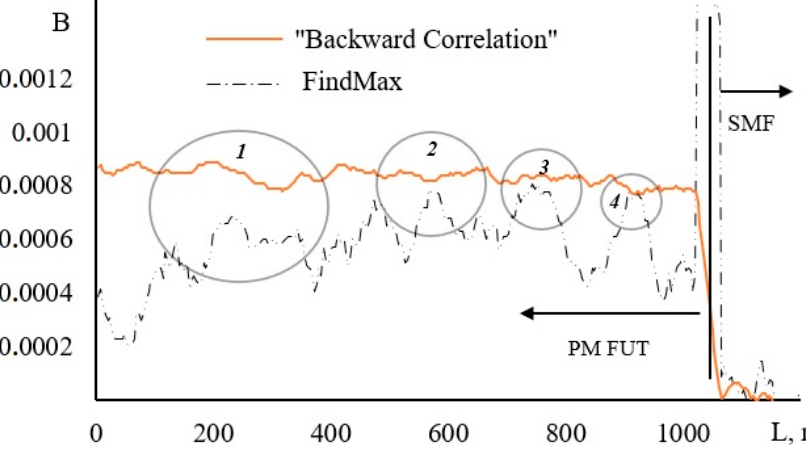
Figure 8. Distribution of modal birefringence along the length of an anisotropic optical fiber. Marked by circles are the four regions where the birefringence changes for both methods have details which look alike.